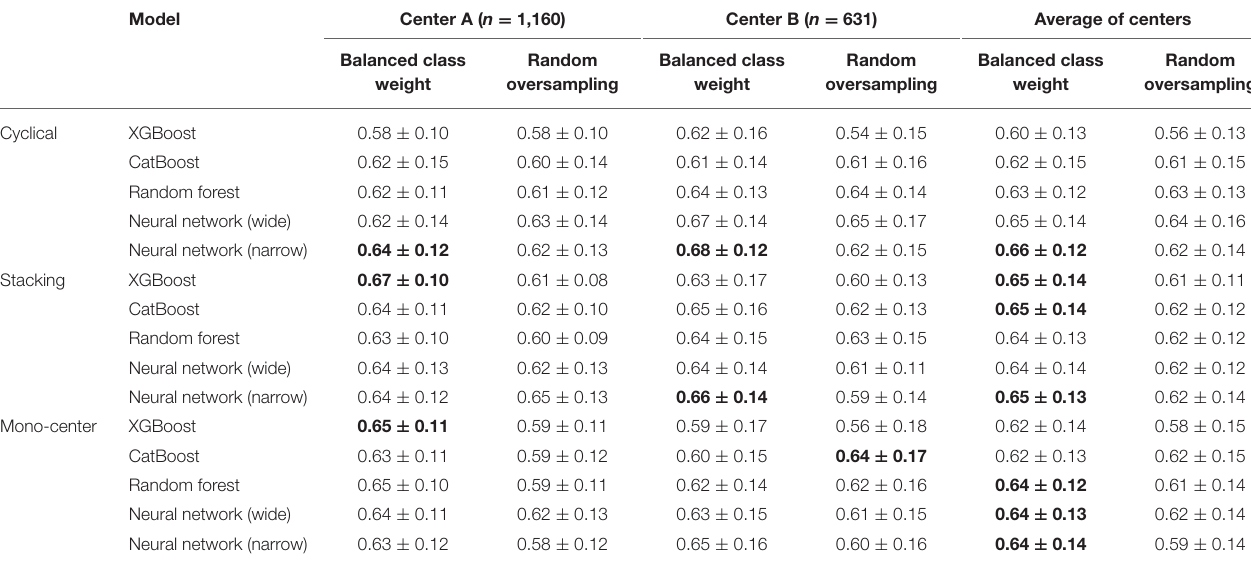
The rows are the classifiers on different setups (cyclical, stacking or internal validation) and the columns are different balancing techniques per center. Highest accuracies per center and on average are highlighted in bold.